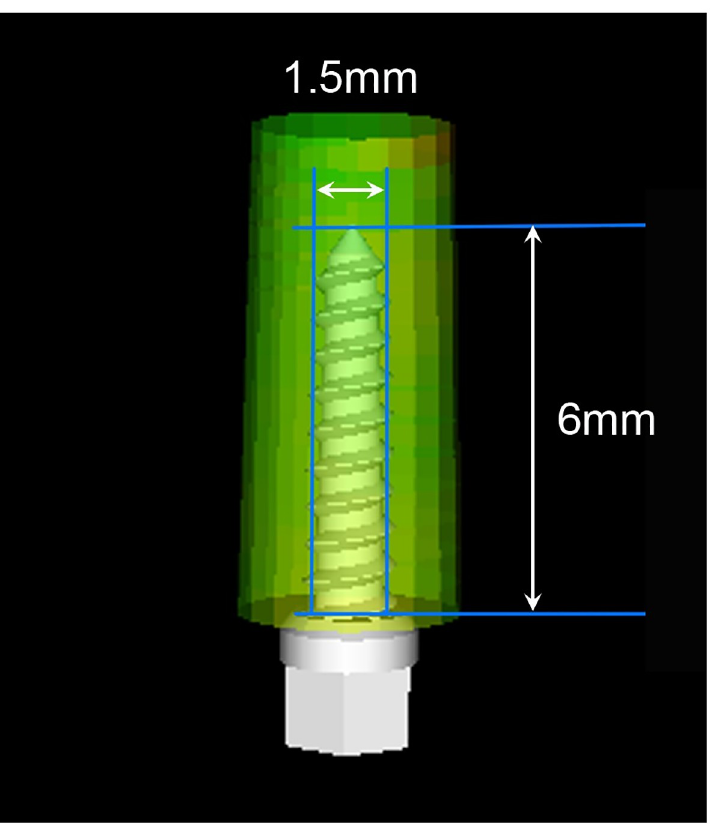
Fig 2. Schematic diagram of a miniscrew. Tapered miniscrew with 1.5 mm diameter and 6 mm length is reconstructed by the InVivo dental